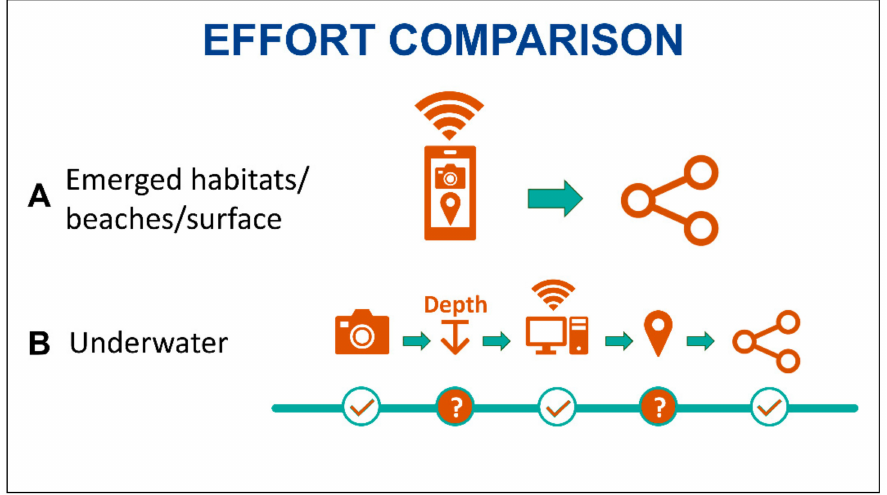
Figure 1. Comparison of steps for taking / sharing records collecting from the ( A ) surface and ( B ) submerged sites. The process requires only two steps using smartphones from the surface and five steps for submerged habitats. This analysis highlights that information about depth and coordinates is generally missing, and that scientists should attempt to fill these gaps during the engagement of scuba